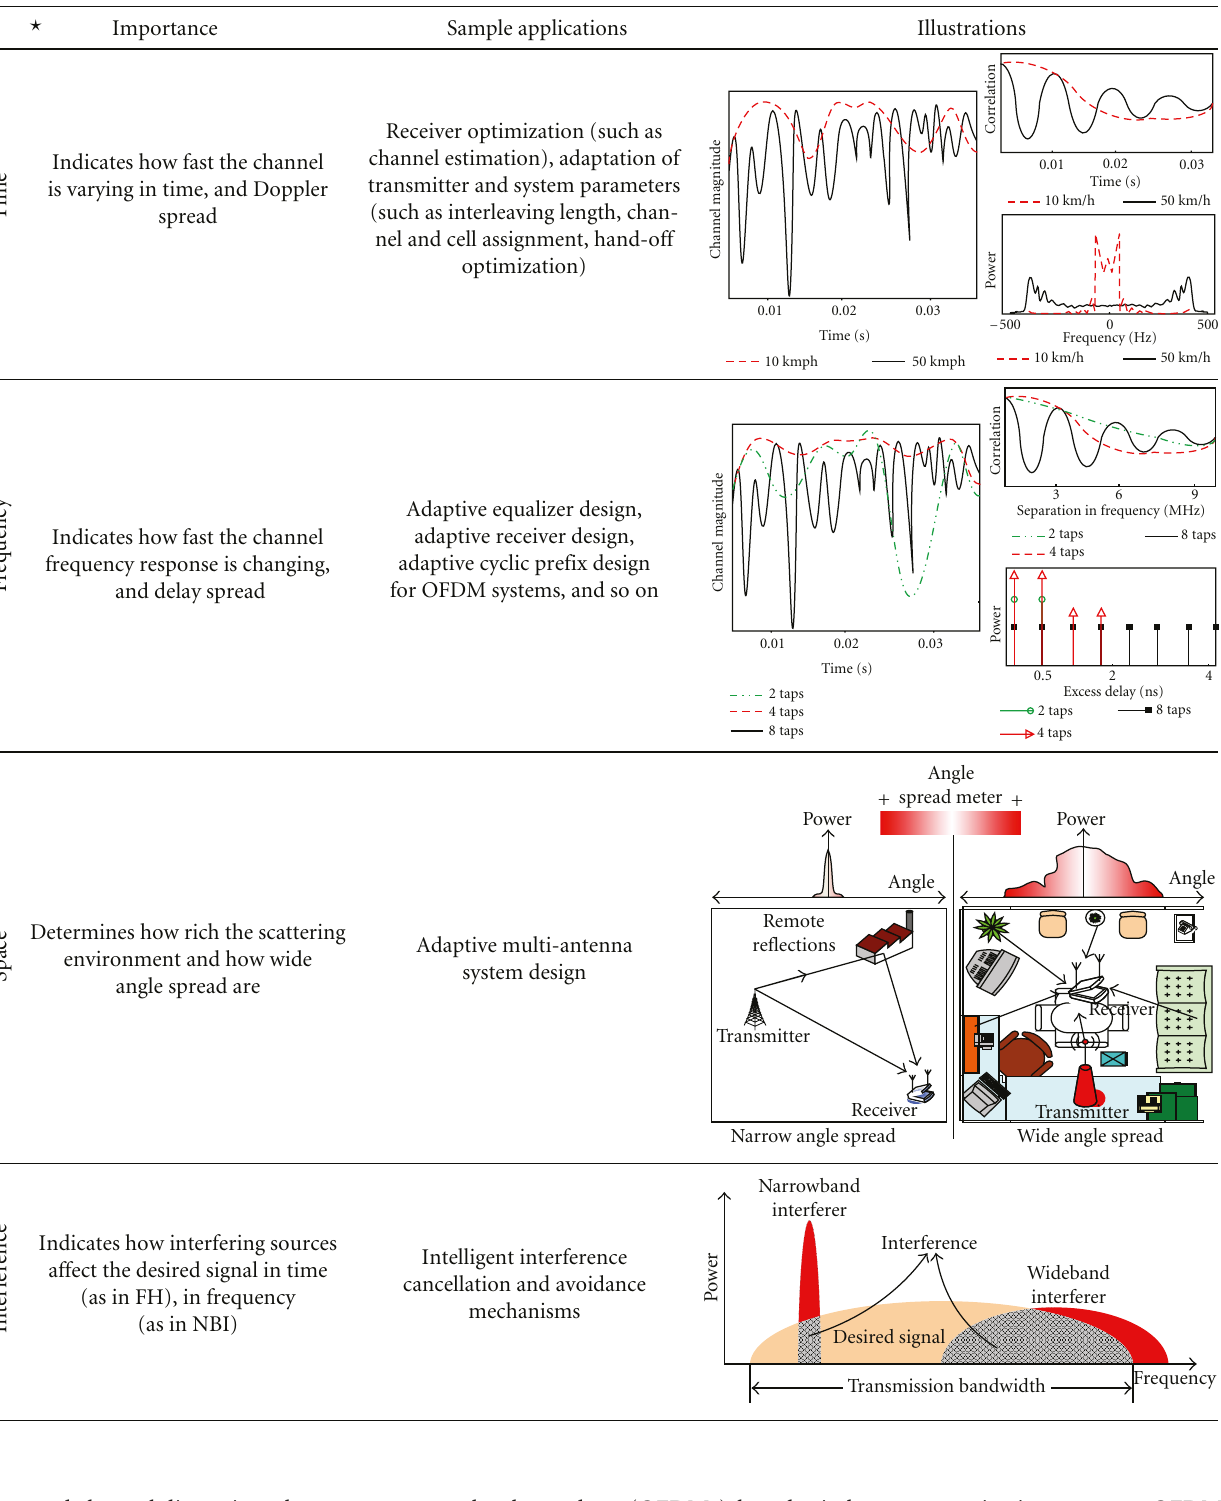
Table 1: Dimension s (cid:2) of channel selectivity and their importance with sample